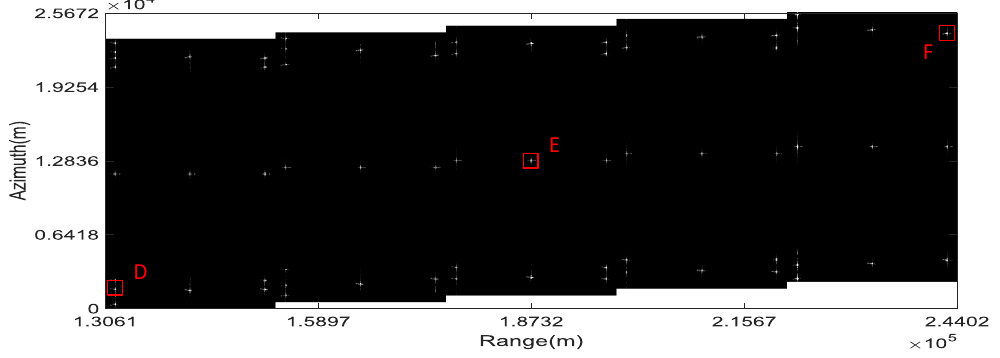
Figure 9. Imaging result of the scheme proposed in [18].